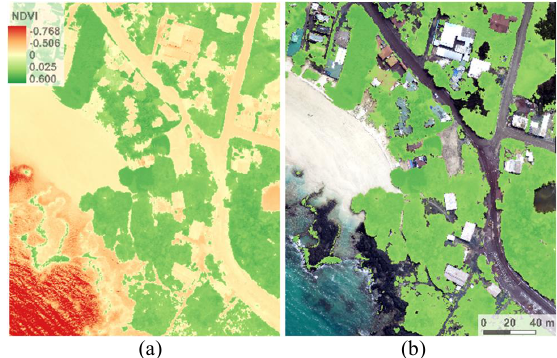
Figure 5. NDVI. (a) NDVI map and (b) masked NDVI with values smaller than